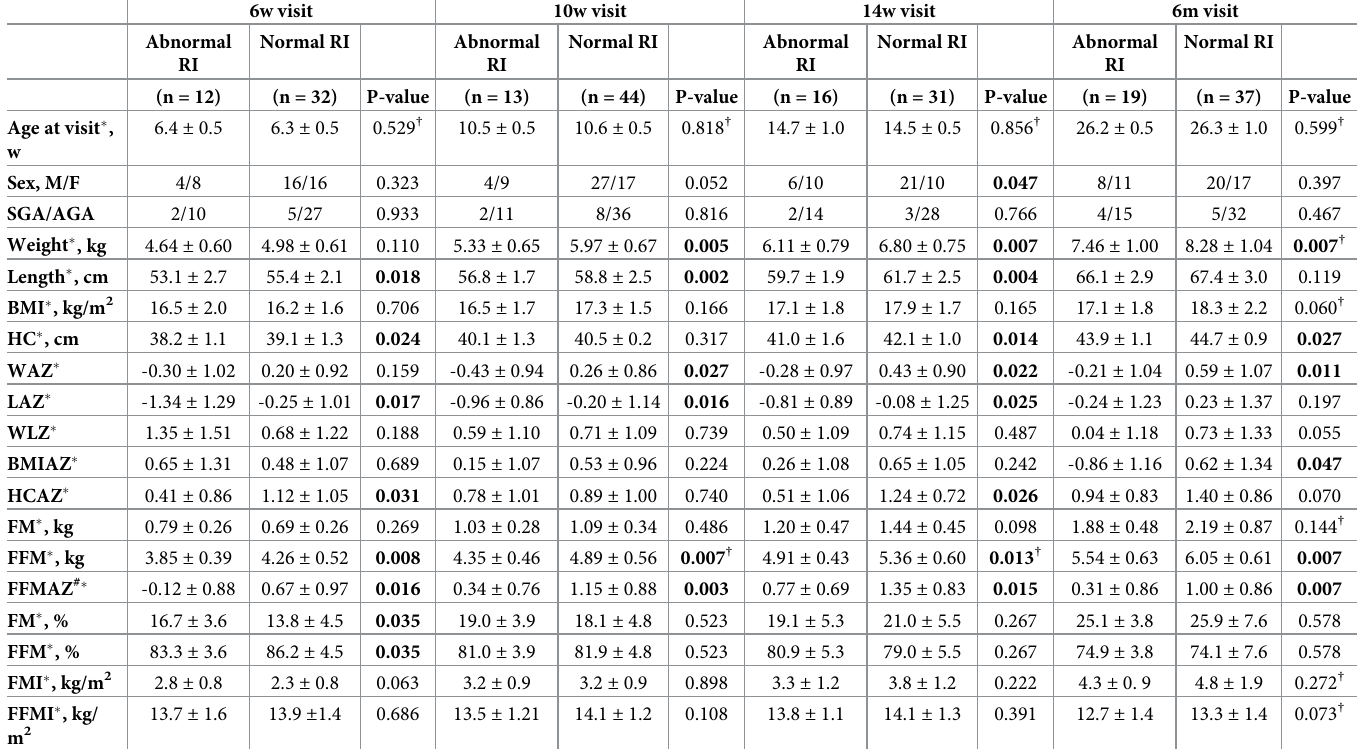
Table 2. Anthropometric and body composition data at child follow-up visits, as grouped by normal and abnormal resistance index of the umbilical artery Doppler during